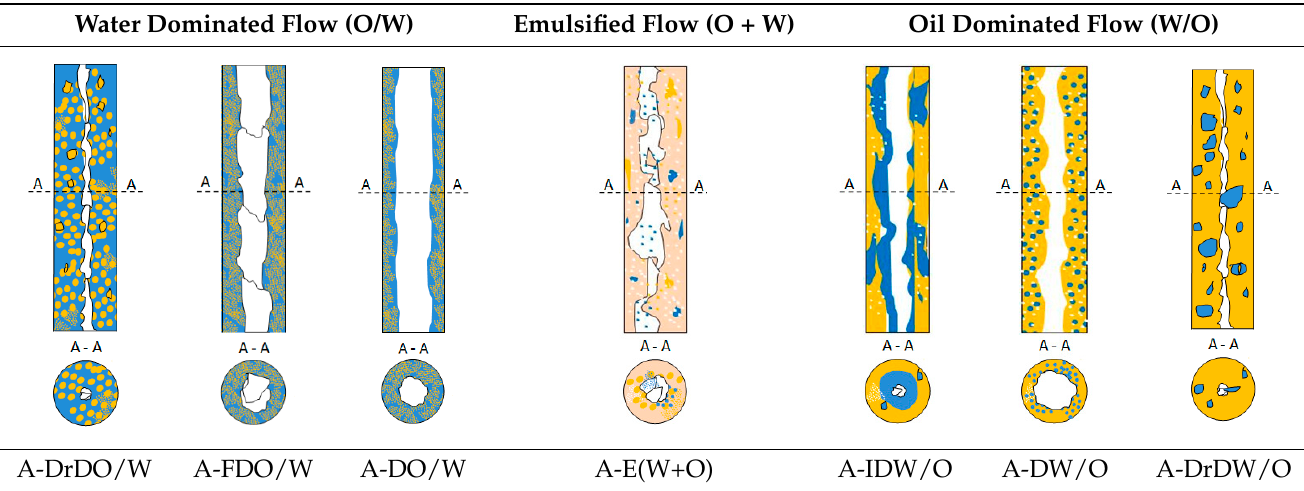
Table 4. Schematic diagrams of gas–liquid–liquid downflow patterns in vertical pipes. Water Dominated Flow (O/W)